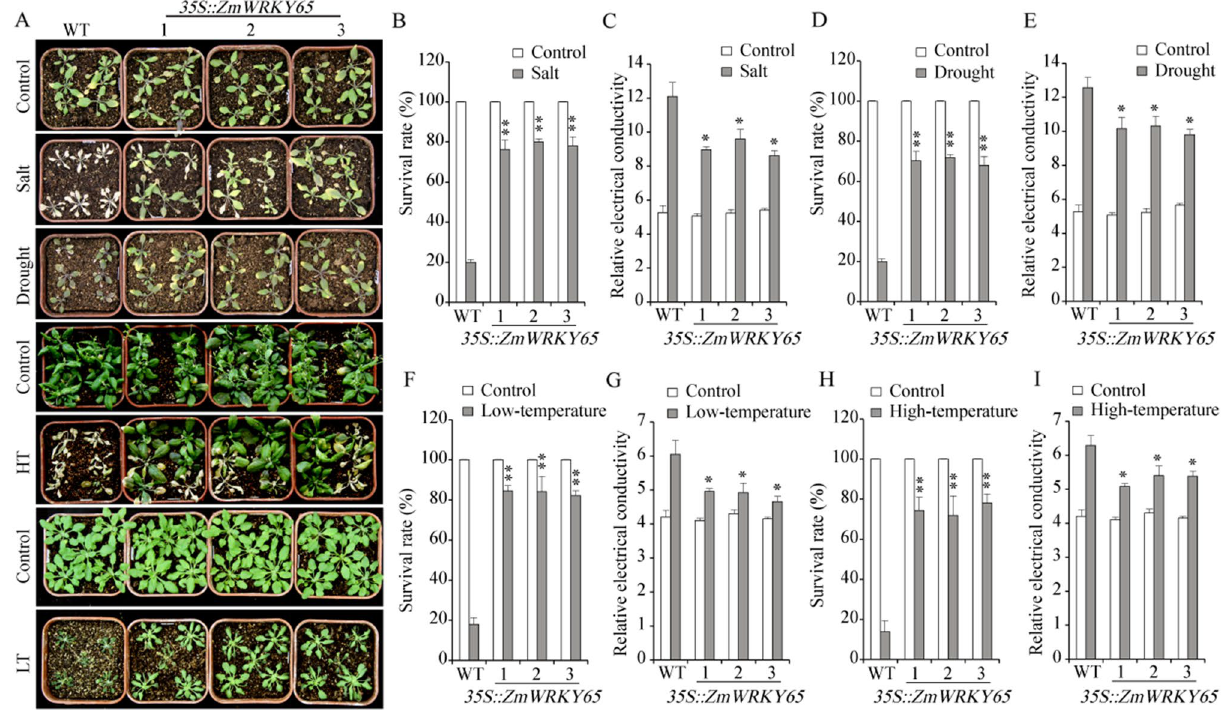
Figure 5. Stress tolerance of WT and transgenic Arabidopsis plants under different treatment conditions. ( A ) The phenotypes of WT and transgenic ZmWRKY65 Arabidopsis plants under different stress treatments. ( B ) and ( C ) The survival rates and relative electrical conductivities of WT and ZmWRKY65 transgenic Arabidopsis plants under salt treatments. ( D ) and ( E ) The survival rates and relative electrical conductivities of WT and ZmWRKY65 transgenic Arabidopsis plants under drought treatments. ( F ) and ( G ) The survival rates and relative electrical conductivities of WT and ZmWRKY65 transgenic Arabidopsis plants under low-temperature treatments. ( H ) and ( I ) The survival rates and relative electrical conductivities of WT and ZmWRKY65 transgenic Arabidopsis plants under high-temperature treatments. The results are averages of three replicates. Vertical bars indicate ± SE of three replicates. *, ** indicate significant differences in comparison with the WT lines at 0.01 < P < 0.05 and P < 0.01, 3 days after inoculation with Pst. DC3000 and 8 days after inoculation with B. cinerea . After being inoculated with Pst. DC3000, the leaves of WT plants were wilted and dried up on the third day; however, the leaves of